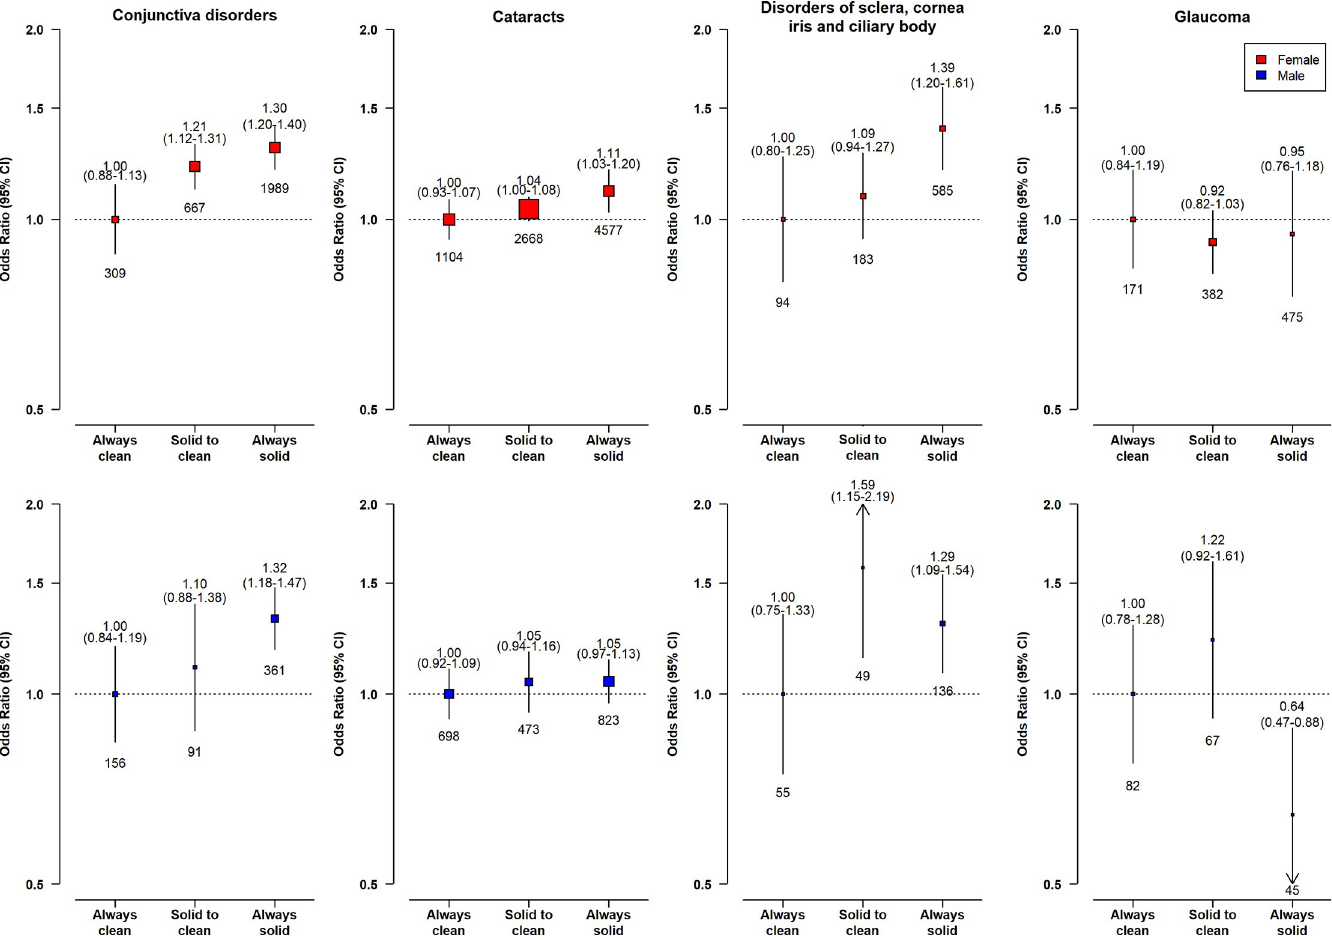
Fig 2. Associations of long-term cooking fuel exposure with for major eye disease incidence in female (red) and male (blue). ORs were adjusted for age at baseline, birth cohort, study area, education, occupation, smoking, environmental tobacco smoke, cookstove ventilation, heating fuel exposure, BMI, prevalent diabetes, self- reported general health, and length of recall period. The graphics are formatted as in Fig 1. BMI, body mass index; CI, confidence interval; OR, odds ratio.